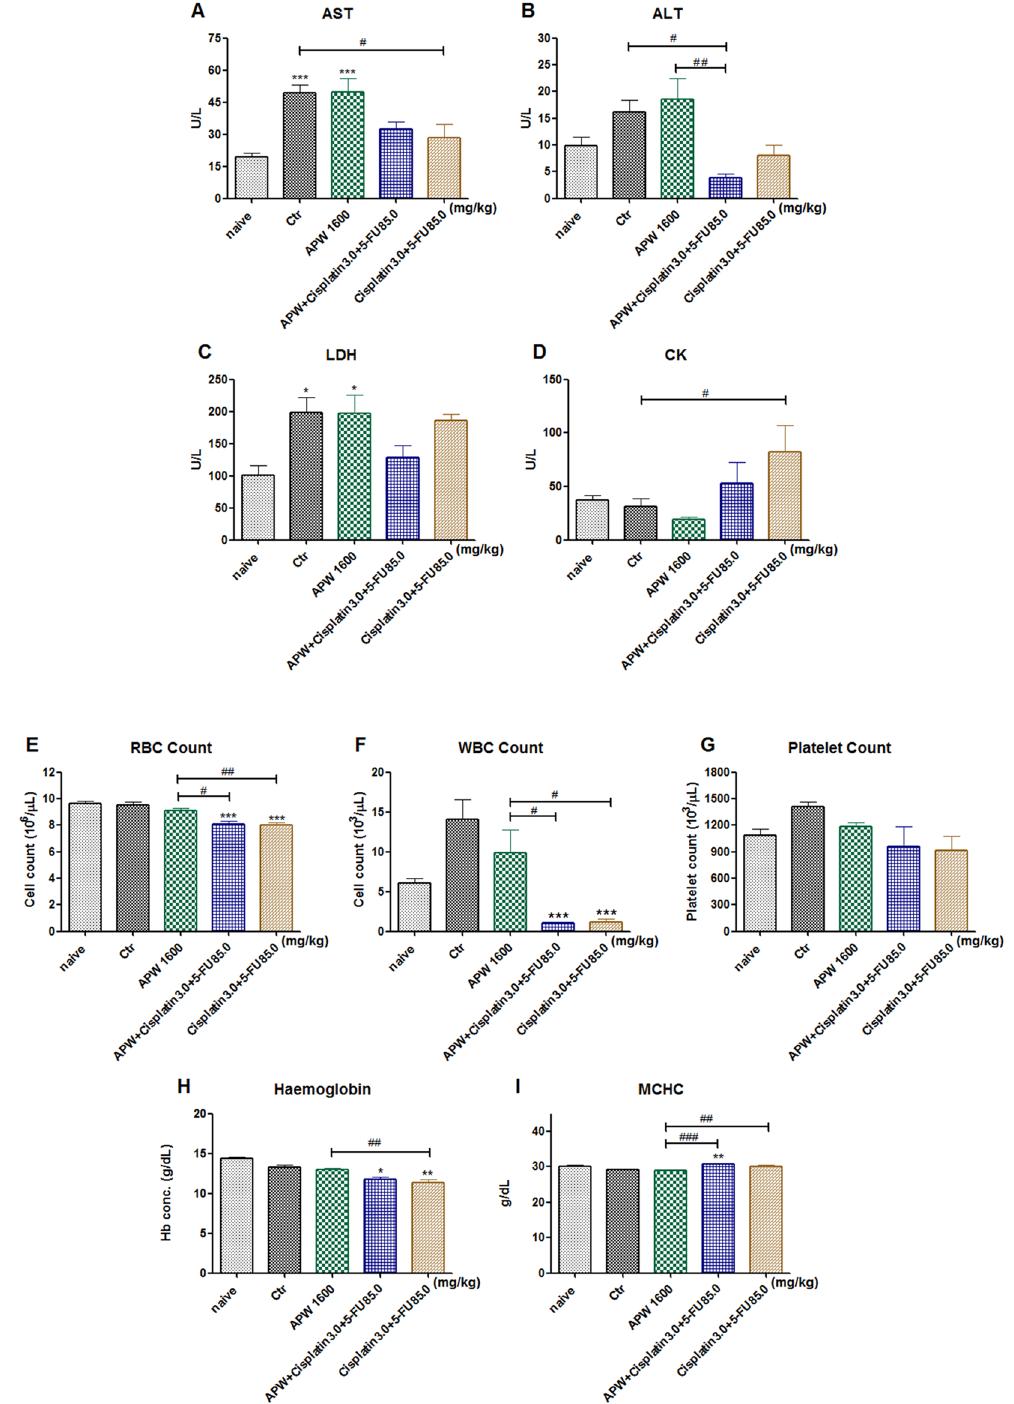
Figure 7. The treatment effects on plasma enzymes, blood cells count and haematological parameters of mice. ( A – D ) Effects of APW alone, the combination of cisplatin and 5-FU and the combination of APW, cisplatin and 5-FU treatments on the levels of plasma enzymes AST, ALT, LDH and CK in EC-109 intraperitoneal xenograft-bearing nude mice after 20 days of treatment. Data are expressed as the mean + S.E.M. of 10–13 samples. * p < 0.05, *** p < 0.001 as compared with naïve; # p < 0.05 as compared with control by one-way ANOVA followed by post-hoc Tukey’s multiple comparison test. ( E – I ) Effects of APW alone, the combination of cisplatin and 5-FU and the combination of APW, cisplatin and 5-FU treatments on blood cells count and haematological parameters of mice. Results were expressed as mean + S.E.M. of 5 mice each group. * p < 0.05, ** p < 0.01, *** p < 0.001 when treatment groups compared with control group. # p < 0.05, ## p < 0.01, ### p < 0.001 as compared among treatment groups by one-way ANOVA followed by post-hoc Tukey’s multiple comparison